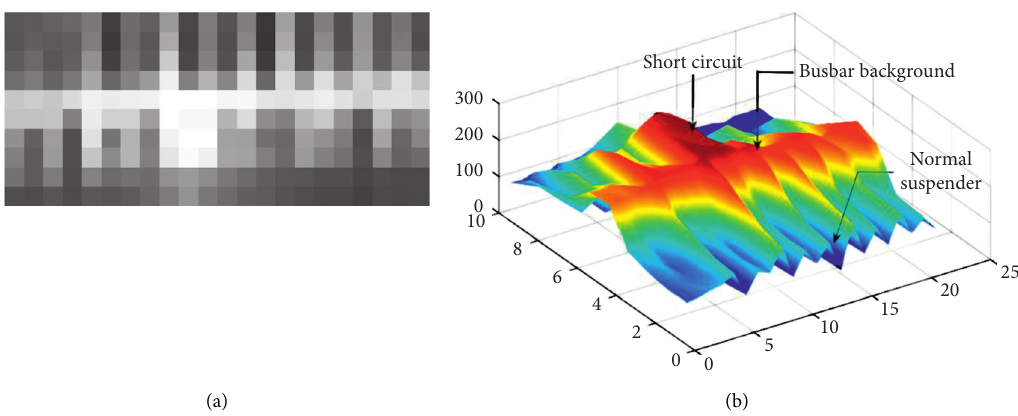
Figure 4: (a) Image patch of intercell busbar area. (b) 3D view of the image